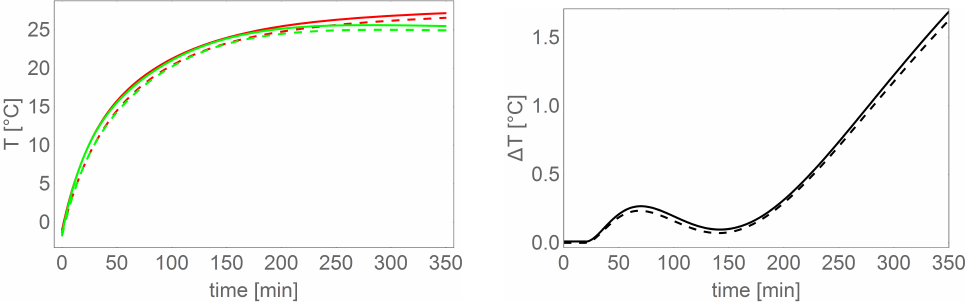
Figure 28. Left chart shows comparison of BLDC motor heating curves ( Te 1 dashed line, Te 2 solid line) for two control variants: sensors in the motor (red), external magnetic disc (green), right chart shows differences between the heating temperatures shown on the left figure.